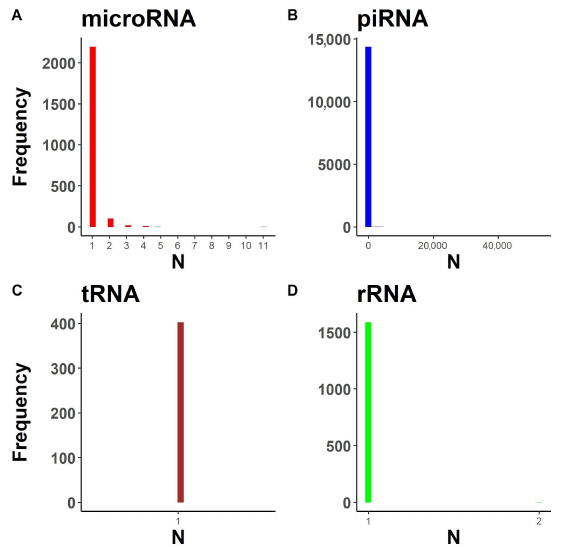
Figure 2. Distribution of loci number per transcript in the databases for various small RNA types.